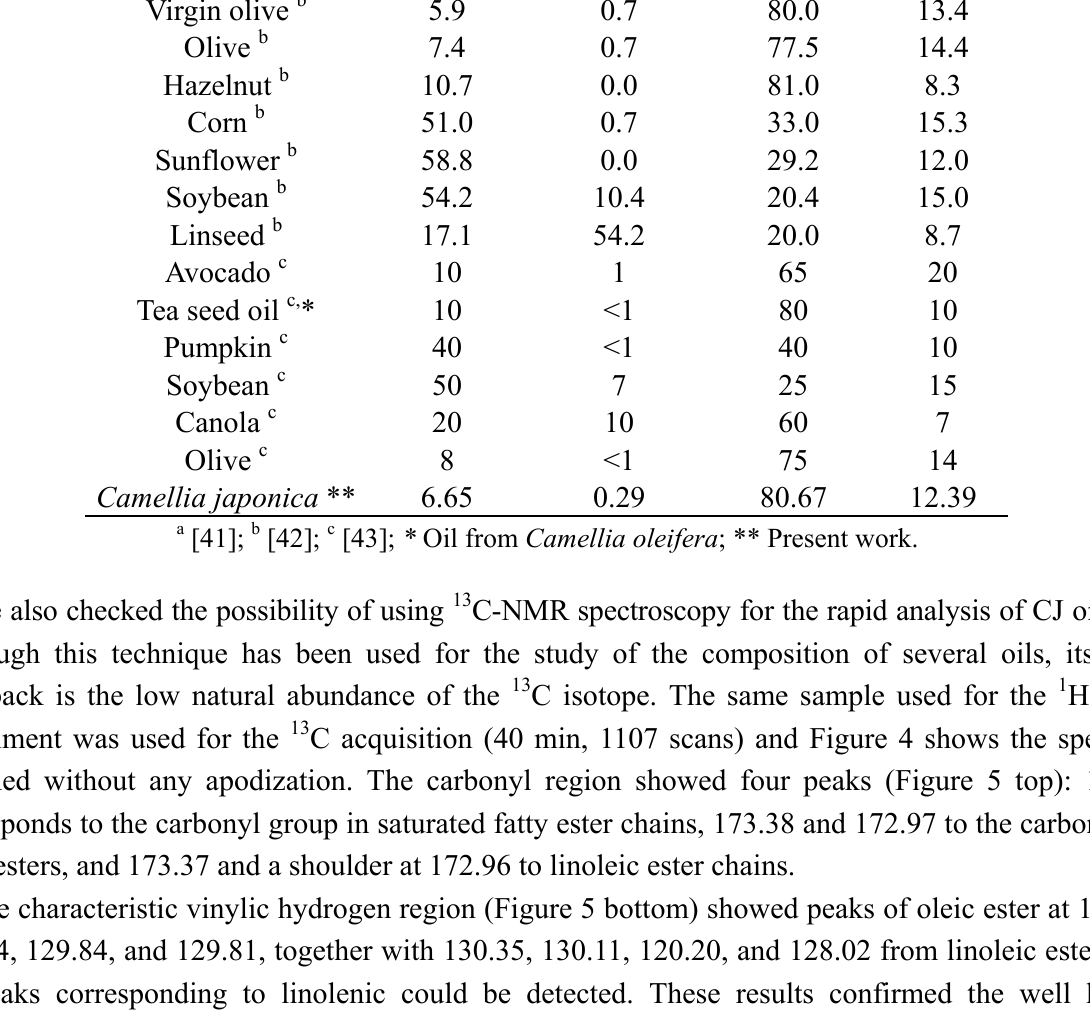
unsaturated fatty acids and total saturated fatty acids 18